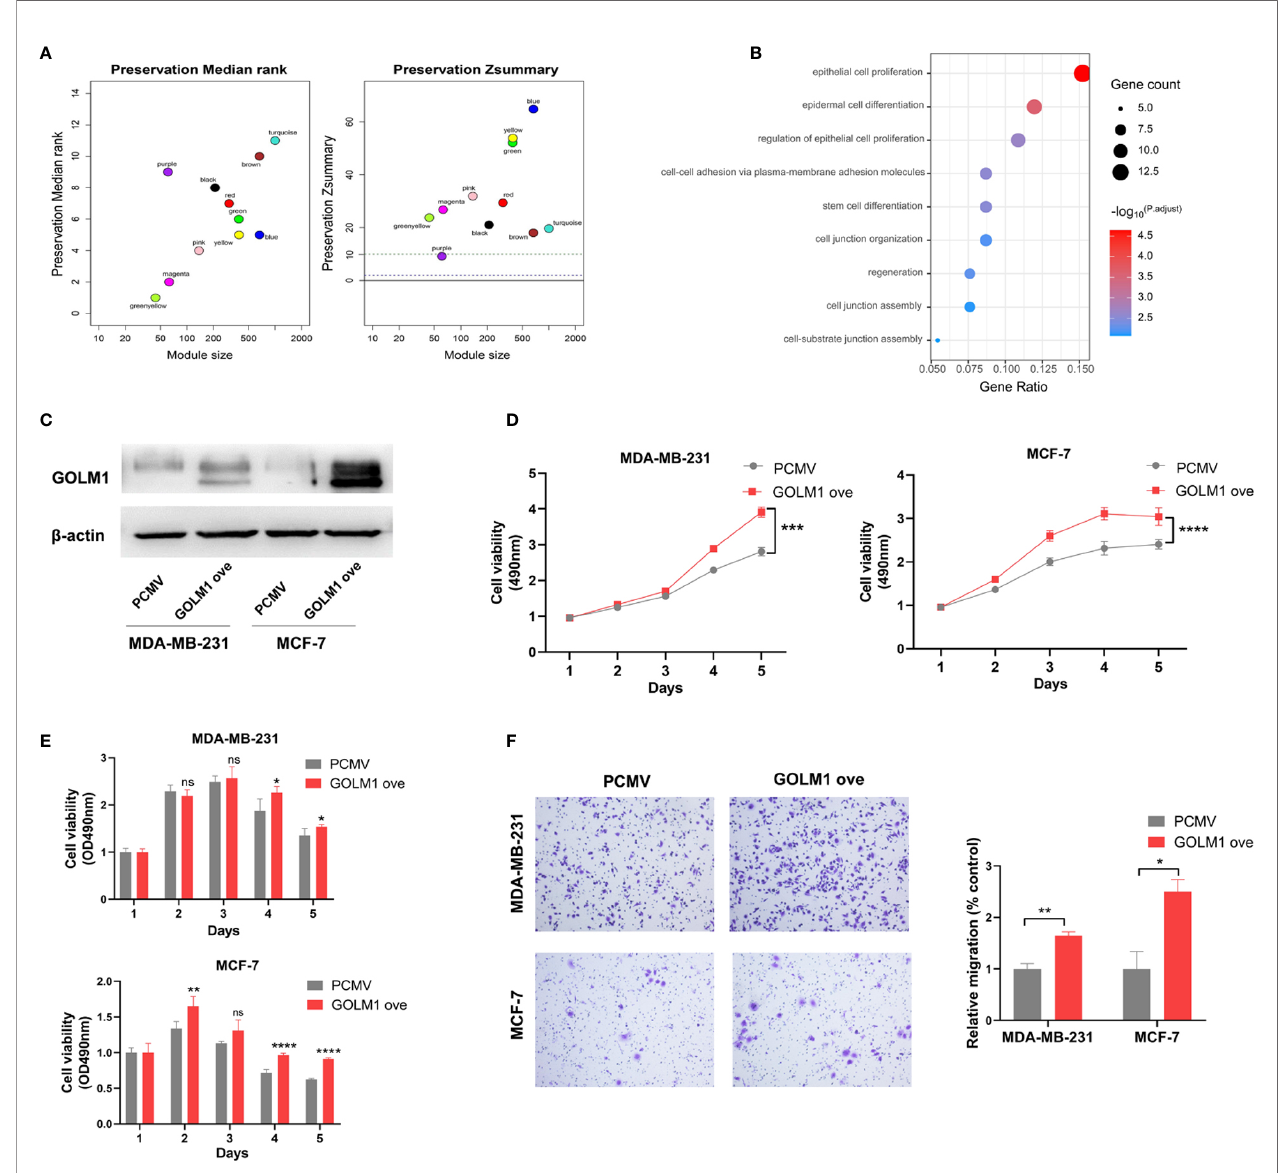
FIGURE 6 | LINC01977 promoted breast cancer progression and chemoresistance to DOX by targeting miR ‐ 212-3p/GOLM1 axis. (A) Module preservation analysis in WGCNA. Each module is represented by its color-code and name. Left plot shows the preservation median rank. Right plot shows the preservation Zsummary value. Zsummary value <10 represented lowly preserved modules. (B) Gene ontology analysis. (C) Expression ef fi ciency of GOLM1 was validated by western blotting assay. (D) MTT assay. (E) Cytotoxicity assay. (F) Cell migration array. (*p < 0.05, **p < 0.01, ***p < 0.001, ****p < 0.0001; Student ’ s